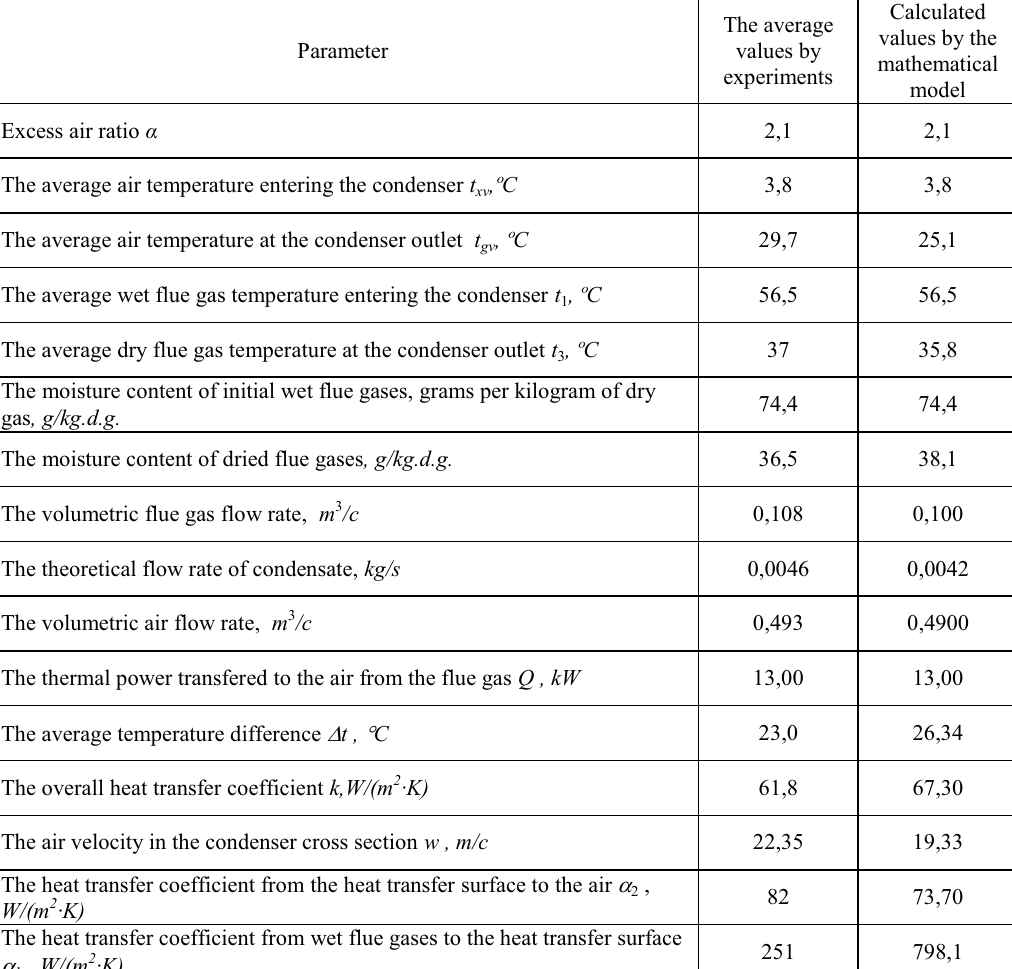
Table 1. Comparing the experimental data with calculated by the mathematical model. Parameter Excess air ratio α 2,1 2,1